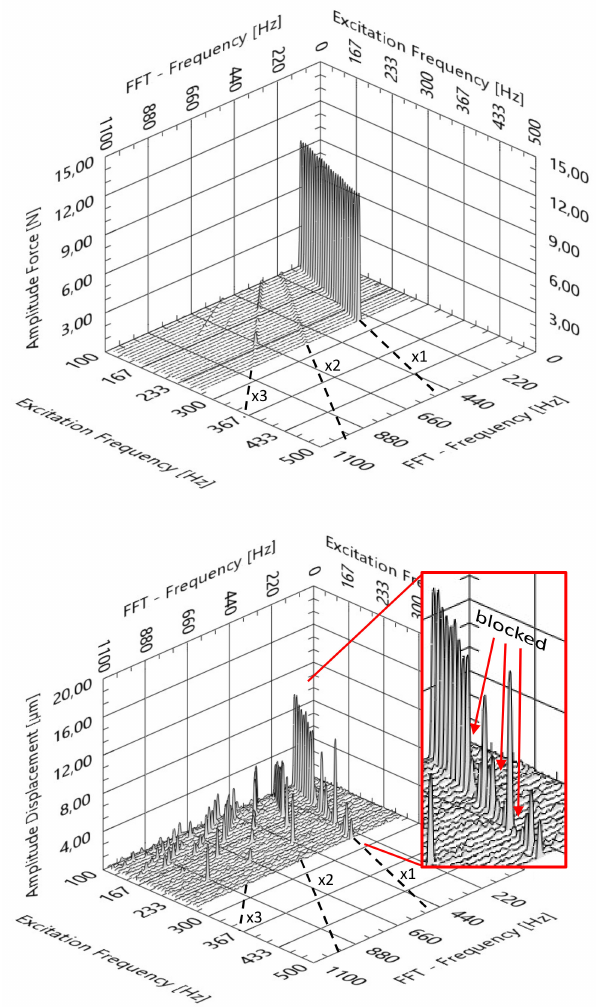
Figure A1. Waterfall plot of force and displacement sensor data in x-direction (11.1 N static load, 10 N force amplitude); cancelled at app. 269